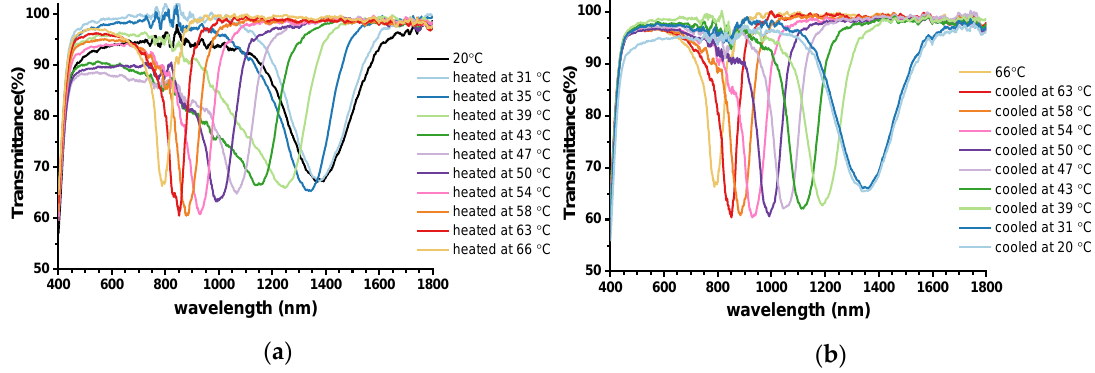
Figure 5. Transmission spectra of the fully cured TP coating recorded during the second heating round ( a ) and the second cooling round ( b ). The thickness of the tested coating was 12 μm.